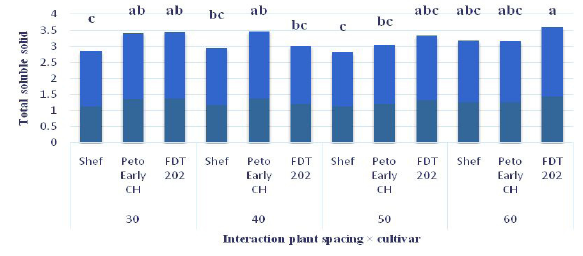
Fig. 1. Interaction between plant spacing × cultivar on total soluble solid